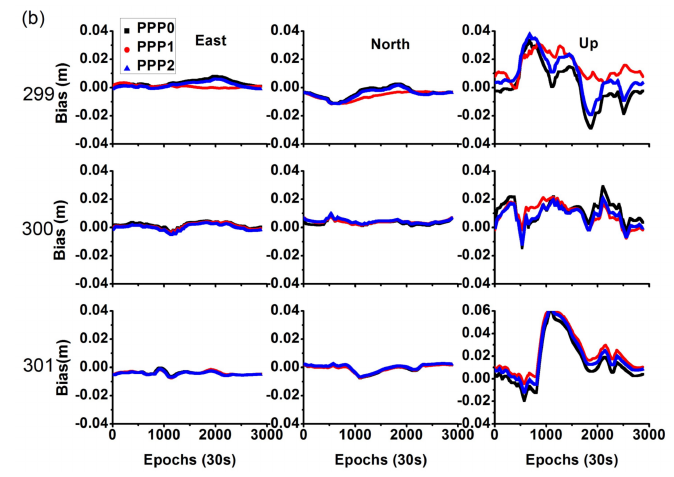
Figure 8. Comparison of position error between different models (( a ) represents NTSA station, and ( b ) represents NTSC station).